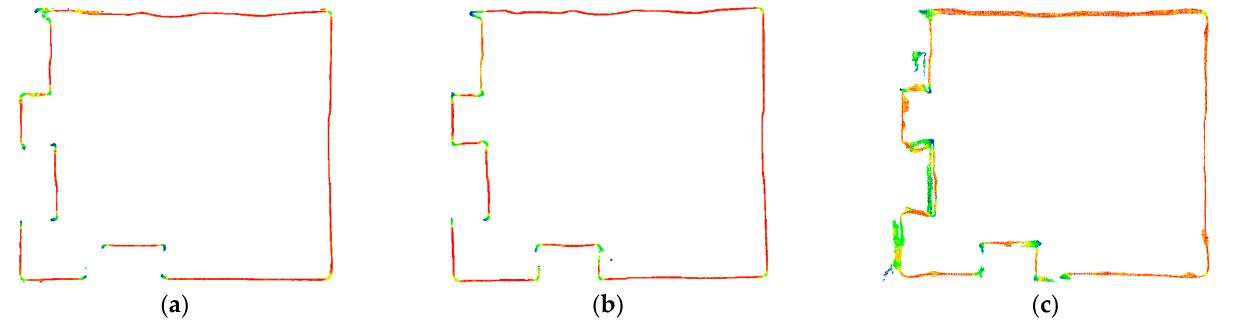
Figure 12. Sections of the point clouds of the laboratory room; scalar field refers to the planarity value: 1 cm resolution scan ( a ), 1.5 cm resolution scan ( b ), 2 cm resolution scan ( c ).